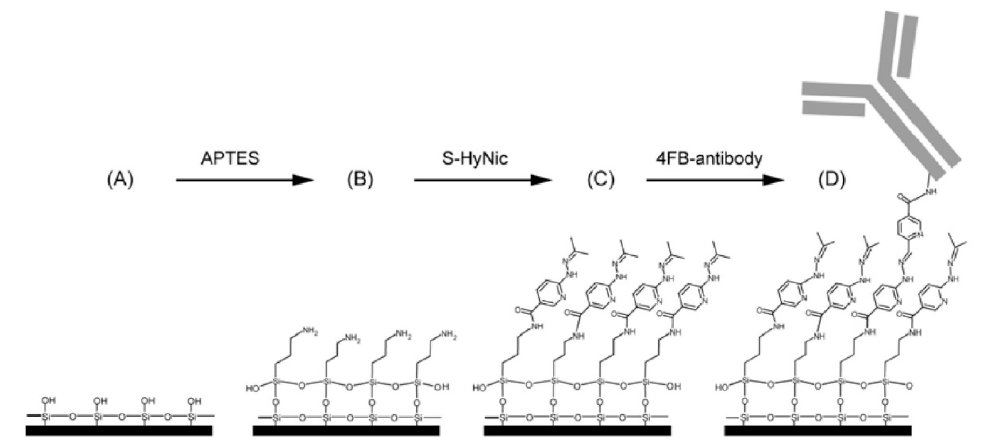
Figure 6. Schematic illustration showing the surface functionalization. ( A ) Silicon surface of micro- ring sensors prior to modification. ( B ) APTES reacts with the surface siloxane groups to generate an amino-terminated surface. ( C ) S-HyNic reacts with primary amines to create a HyNic-displaying surface. ( D ) Addition of 4FB-modified antibodies results in hydrazone bond formation between the 4FB moieties on the antibodies and the HyNic moieties on the surface. (Reproduced from reference